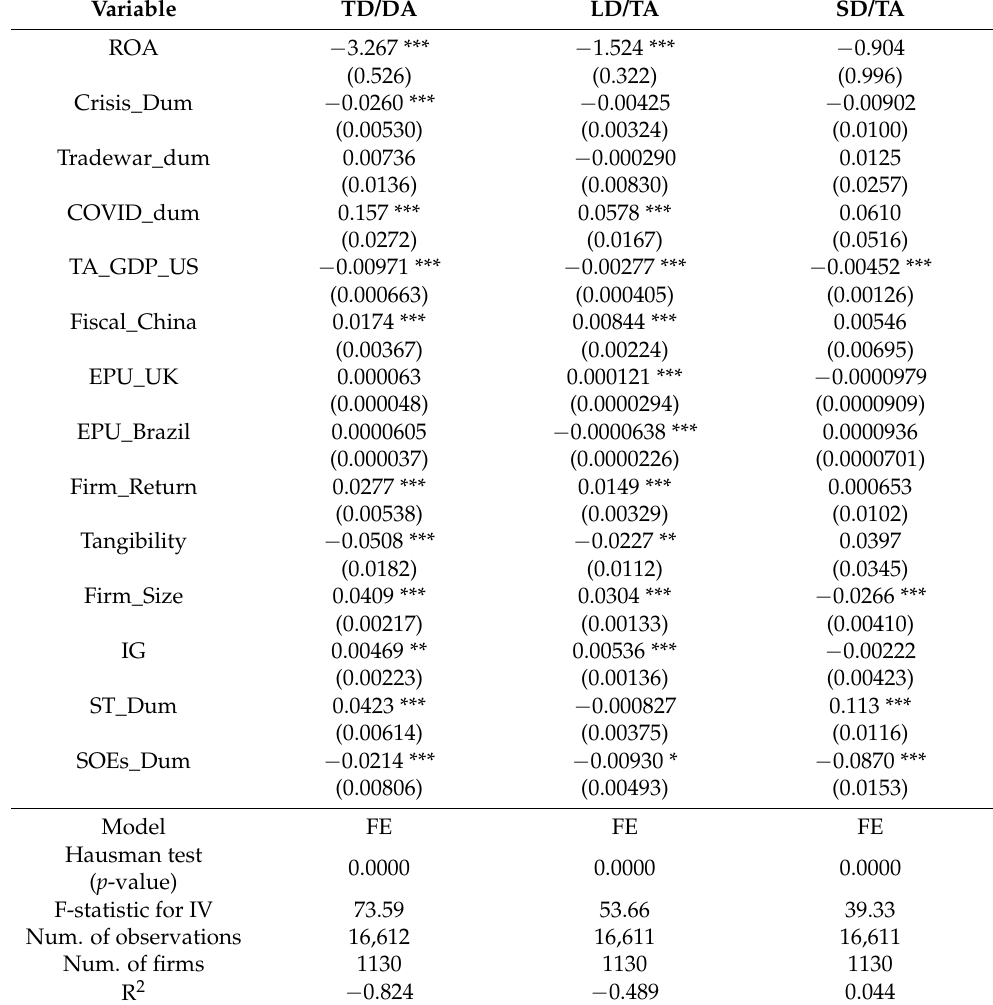
Table 8. The impacts of the Great Recession, Trade War, and COVID-19 on capital structure: instru- mental variable